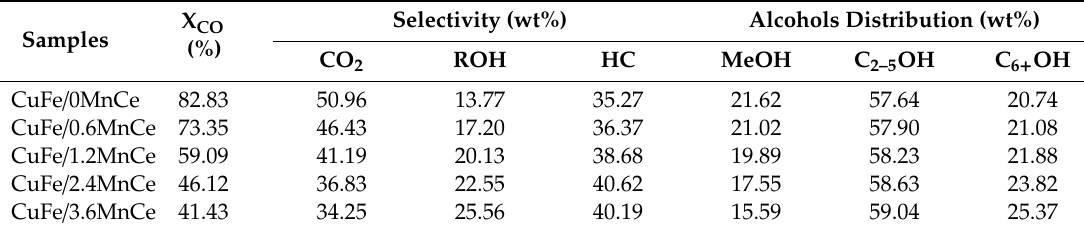
Table 3. HAS evaluation results of CuFe / xMnCe catalysts.